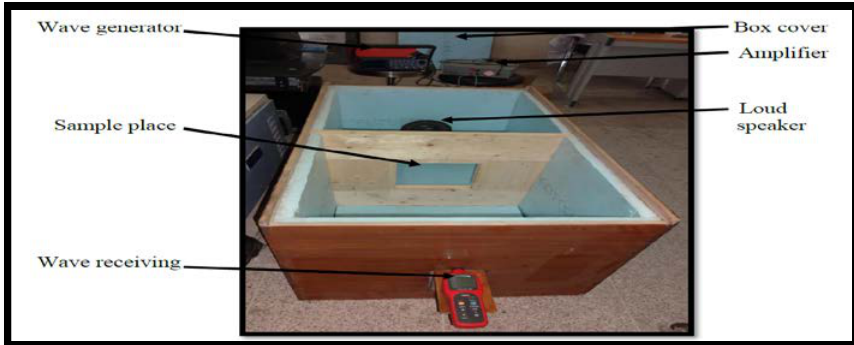
Fig. 4: Sound insulation